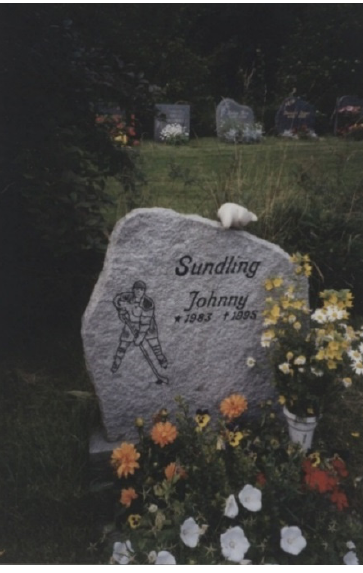
Figure 4. An ice hockey player incised on the gravestone of the twelve-year-old Johnny Sundling, 1983–1995, in Norum Cemetery in Bohuslän, Sweden. Photo: Anders